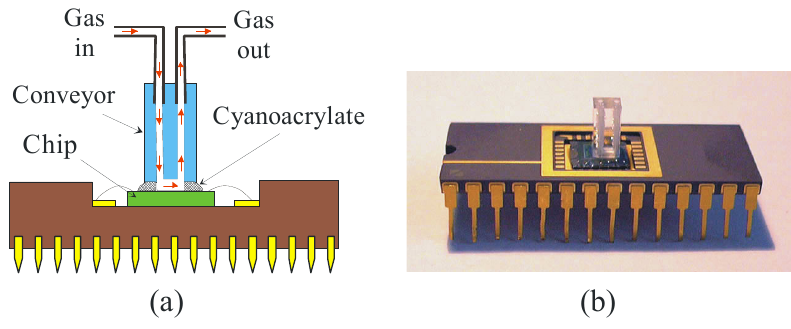
Figure 7. ( a ) Schematic view and ( b ) photograph of the assembled